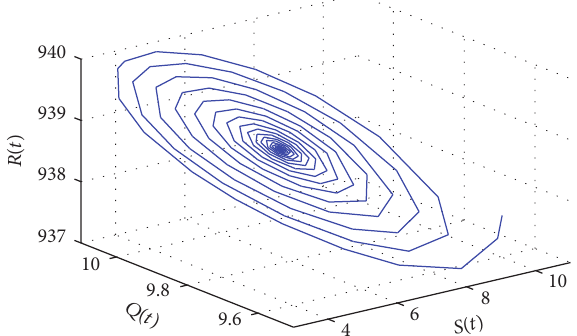
Figure 3: The phase plot of 𝑆 , 𝑄 , and 𝑅 when 𝜏 1 = 1.3025 < 1.3265 = 𝜏 10